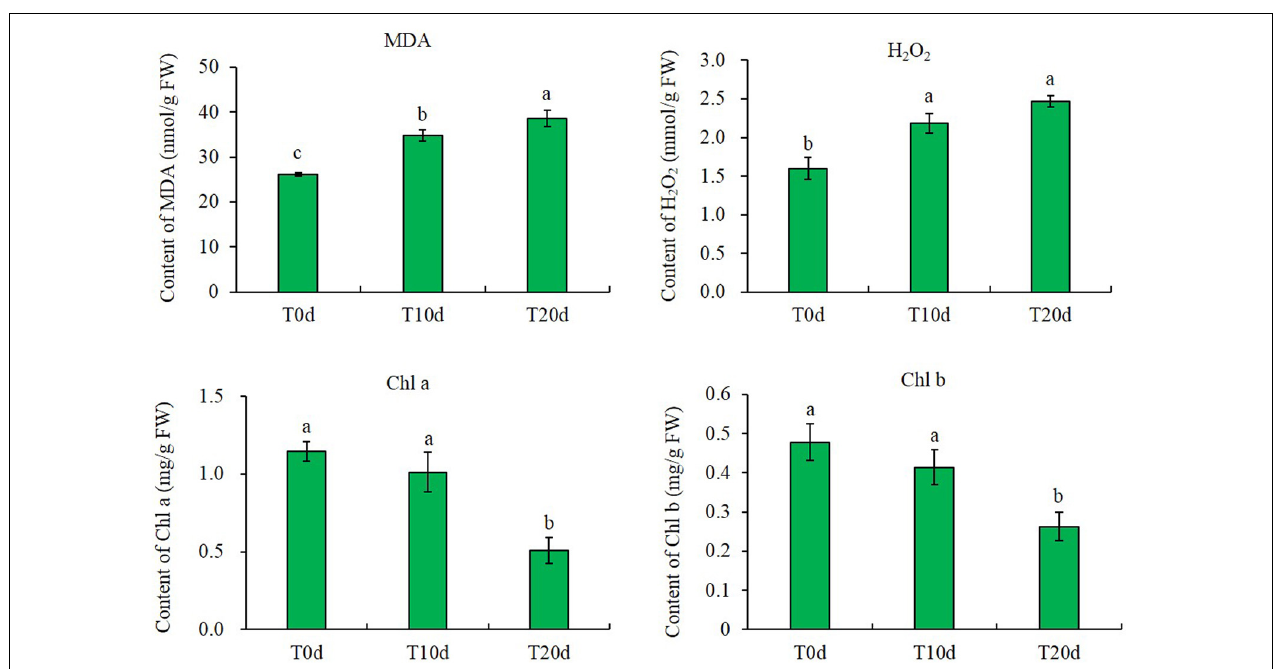
FIGURE 2 | MDA, H 2 O 2 , and chlorophyll contents in different treatments. Columns with the same letter were not significantly different at p < 0.05.